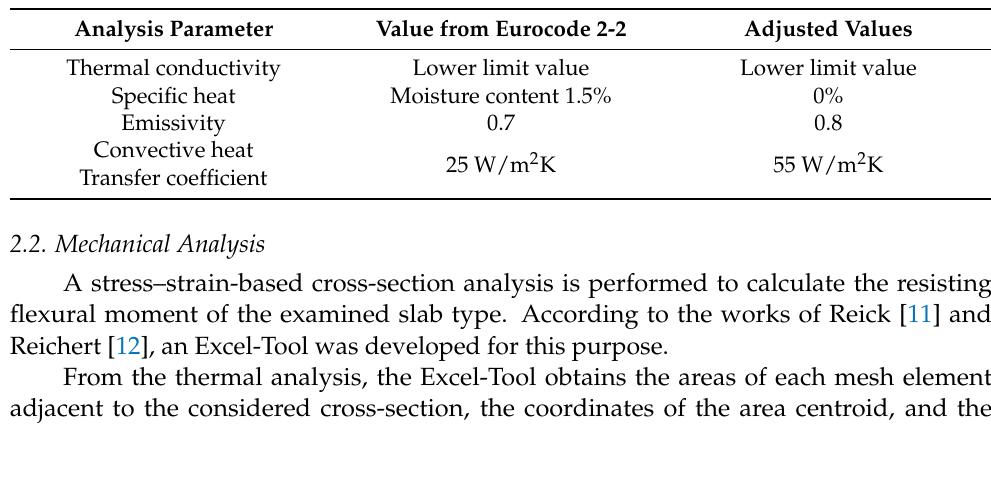
Figure 4. Temperature profiles for a slab provided in [5], Annex A, compared to simulation results with standard parameters ( left ) and adjusted parameters ( right ). Table 1. Analysis parameters according to [5] and adjusted values chosen for the